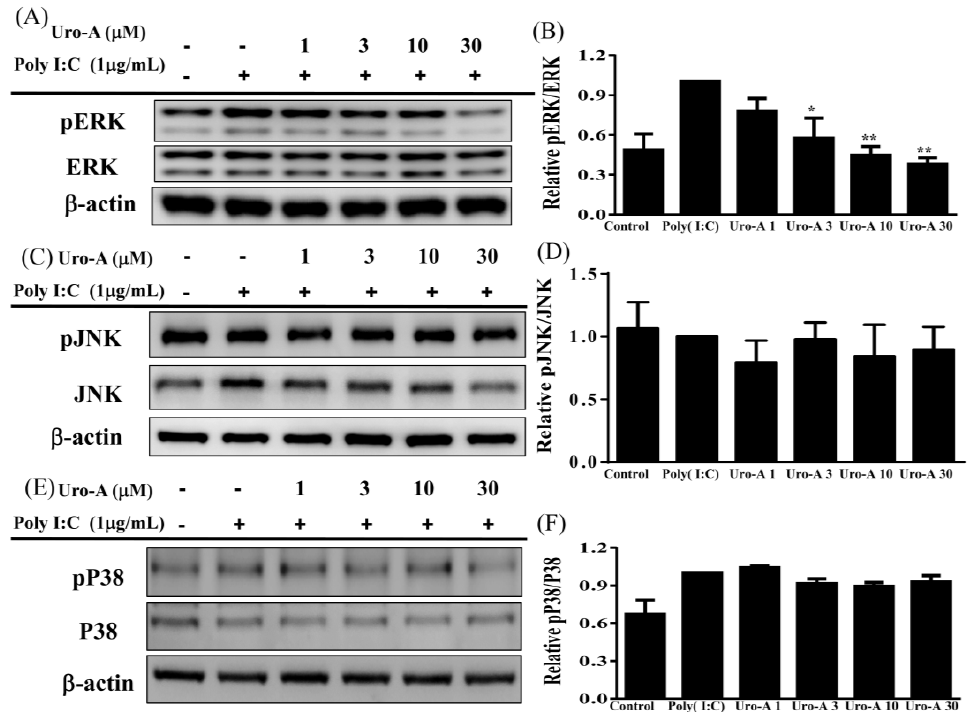
Figure 5. Urolithin A (Uro-A) inhibited inflammatory pERK signaling in poly(I:C)-induced RAW264.7 cells. ( A ) pERK and ERK protein expression. ( B ) Fold-change in pERK expression relative to ERK expression. ( C ) pJNK and JNK protein expression. ( D ) Fold-change in pJNK expression relative to JNK expression. ( E ) pP38 and P38 protein expression. ( F ) Fold-change in pP38 expression relative to P38 expression. RAW264.7 cells were precultured with various concentrations of Uro-A, and then incubated with poly(I:C) (1 μ g/mL) for 30 min or 24 h. Data are presented as mean ± SD. * p < 0.05, ** p < 0.01 compared to RAW264.7 cells stimulated with poly(I:C) alone.